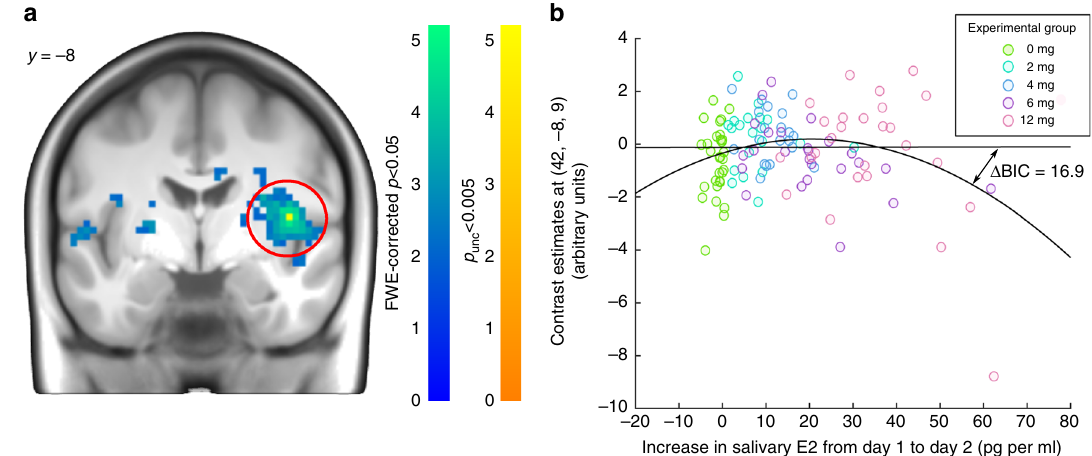
Fig. 7 Relationship between E2 increase and the emotional enhancement of memory contrast. a Statistical t-map of the negative quadratic relationship between salivary Day 1 to Day 2 increase in 17-beta-estradiol (E2) and the emotional enhancement of memory (EEM; hit > miss × negative > neutral) contrast in the right insula ( N = 121; FWE-corrected p = .015; t -test). The statistical map is thresholded at FWE-corrected p < .05 (warm color scale) and p unc < .005 (cold color scale) for visualization purposes. b Robust regression analysis between contrast estimates (y-axis) and salivary E2 increase (x-axis) con fi rmed the inverted U-shaped relationship. Difference in Bayesian Information Criterion ( Δ BIC) between the linear and quadratic model was 16.9, strongly evidencing a better model fi t of the quadratic compared to the linear model. Colors represent experimental